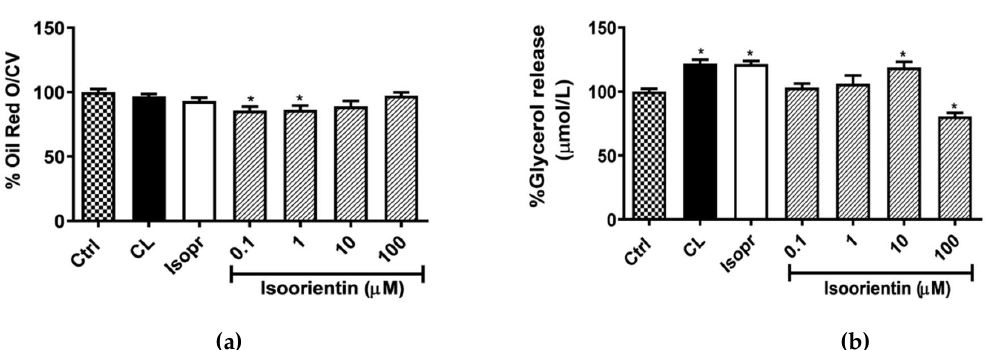
Figure 2. Isoorientin reduced lipid accumulation ( a ) and increased glycerol release ( b ) in 3T3-L1 adipocytes. Matured 3T3-L1 adipocytes were treated with or without positive CL-316,243 (CL), isoproterenol (Isopr) used at 1 μM and various doses of isoorientin (0.1, 1, 10, and 100 μM) for 4 hours; subsequently, lipid accumulation was measured with Oil Red O and confirmed with glycerol release assay. Results are expressed as mean ± SEM of three independent experiments. * p < 0.05 versus normal control (Ctrl).